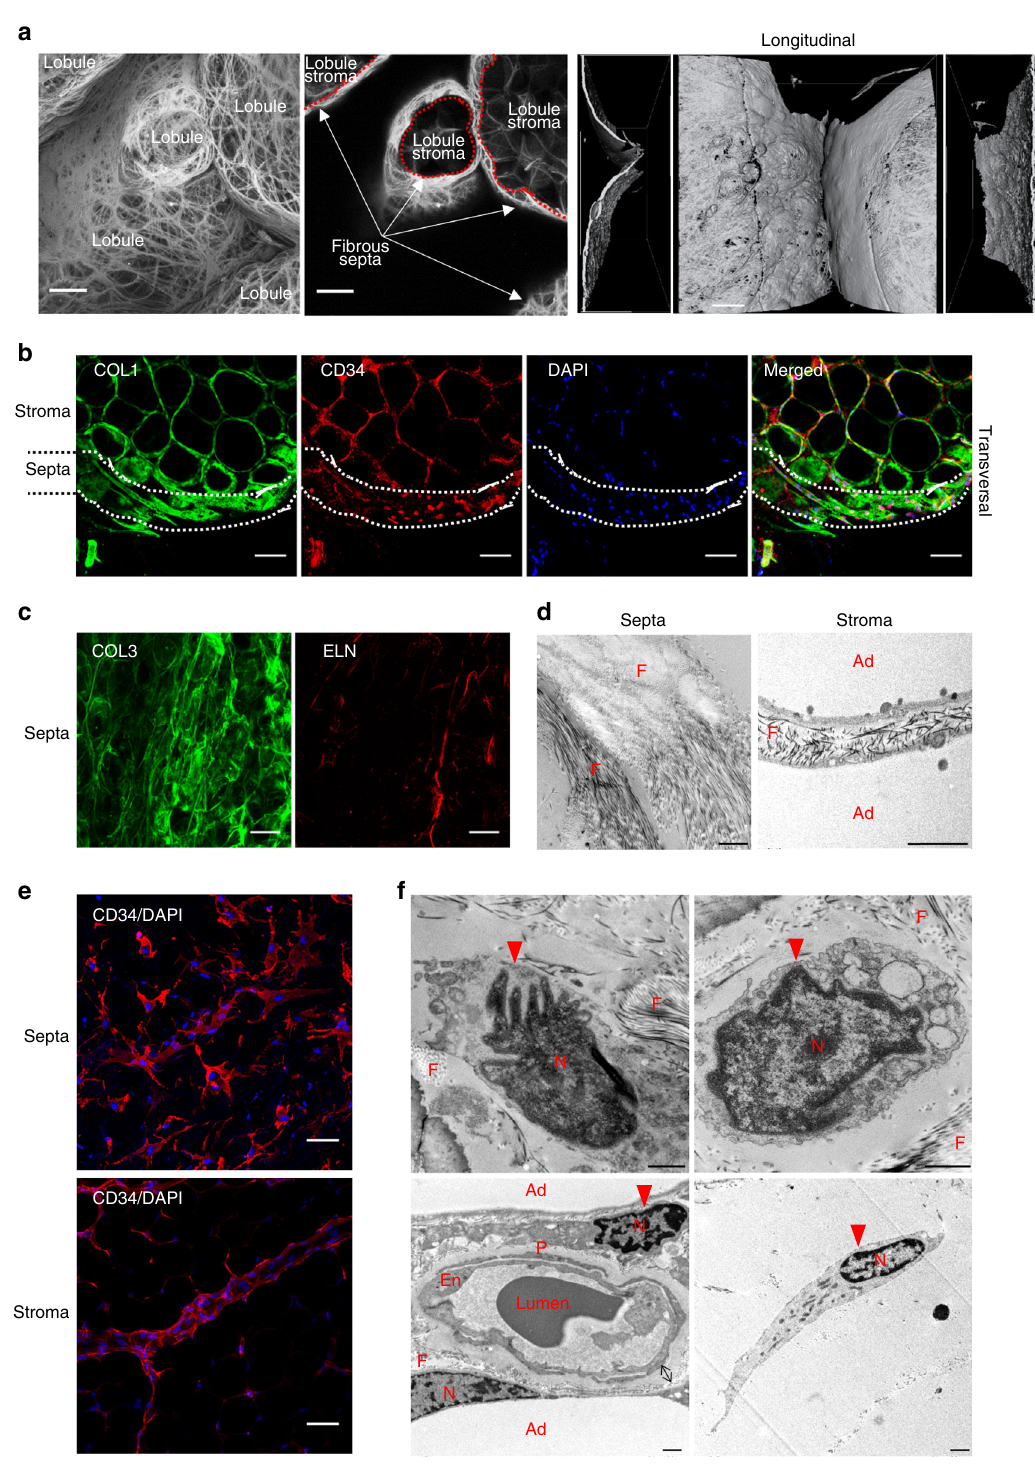
SC progenitor subsets display distinct potentials . RNA sequencing (RNAseq) was performed on matched native − / − , − /CD271 + , and MSCA1 + subsets isolated from subcutaneous (SC) AT of fi ve distinct obese donors. Paired sparse partial least- squares discriminant (sPLS-D) analyses discriminated transcripts exhibiting progenitor subset-speci fi c pro fi les clustering − / − subset with MSCA1 + subset followed by − /CD271 + subset (Fig. 3a). The progenitor subset-speci fi c transcripts were enriched in pathways related to cellular and developmental processes,